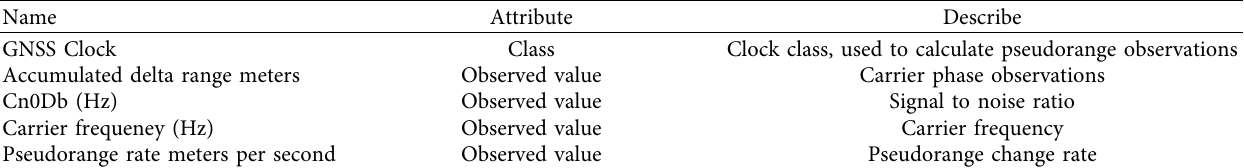
Table 1: Te main observations are available for the 5G smart communication base